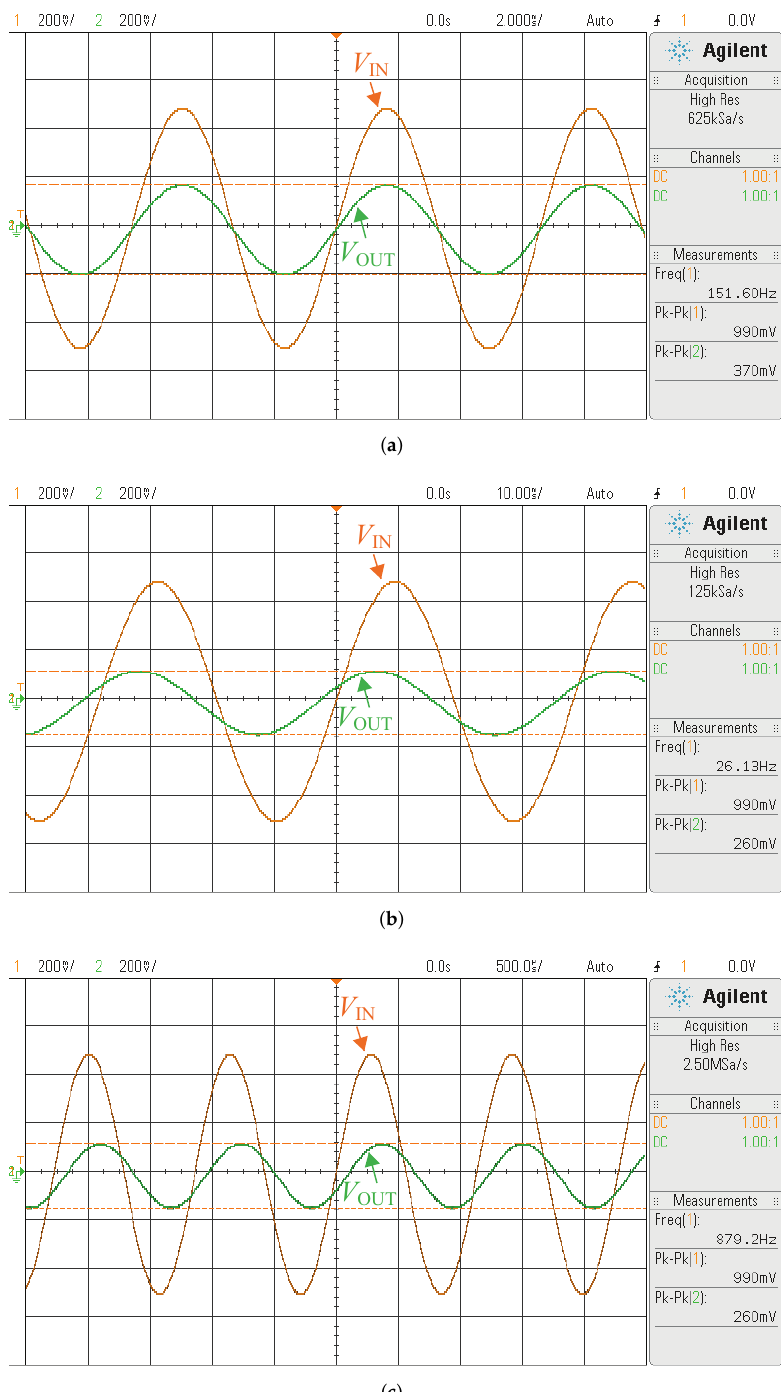
Figure 15. Time-domain input-output waveforms observed in oscilloscope for the proposed FBPF with an input frequency of ( a ) ω 0 = 952.53 rad/s, ( b ) ω H,low = 164.18 rad/s, and ( c ) ω H,high = 5.52